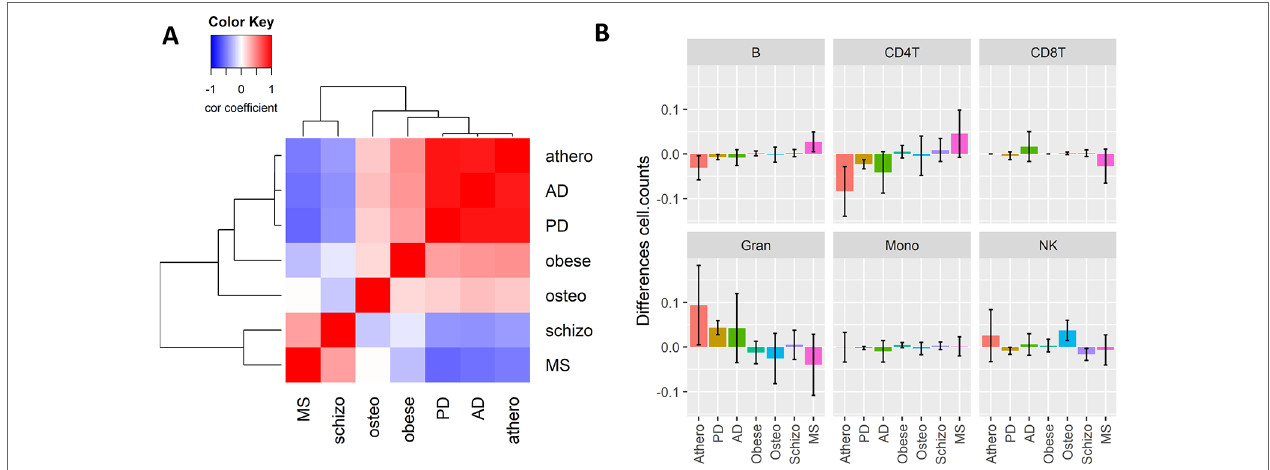
FIgURe 5 | The Weighted Correlation Network Analysis co-methylation consensus module in whole blood of other inflammaging diseases. (A) Correlation heatmap representing the Pearson's correlation coefficients between the gene significance values (t-statistics) of the consensus module ME21 CpG sites across six chronic inflammaging diseases: atherosclerosis (athero), Alzheimer's disease, Parkinson's disease, obesity (obese), osteoporosis (osteo), schizophrenia (schizo), and multiple sclerosis (see Table 2 ). Red means a positive correlation and blue a negative correlation. (B) Estimated blood immune cell type composition shifts in the different chronic inflammaging diseases compared to healthy controls. Error bars represent 95% confidence